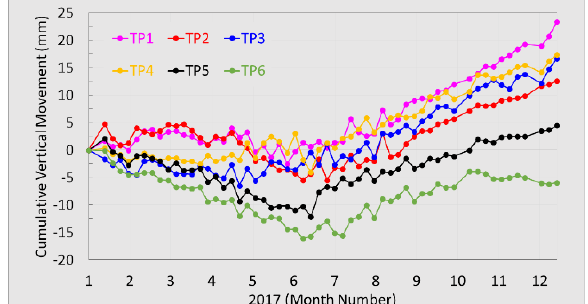
Figure 5. Cumulative vertical movement (mm) of target points (TP) 1 – 6 (Figure 3) in 2017 before fitting. Positive and negative, up and down movements, respectively.